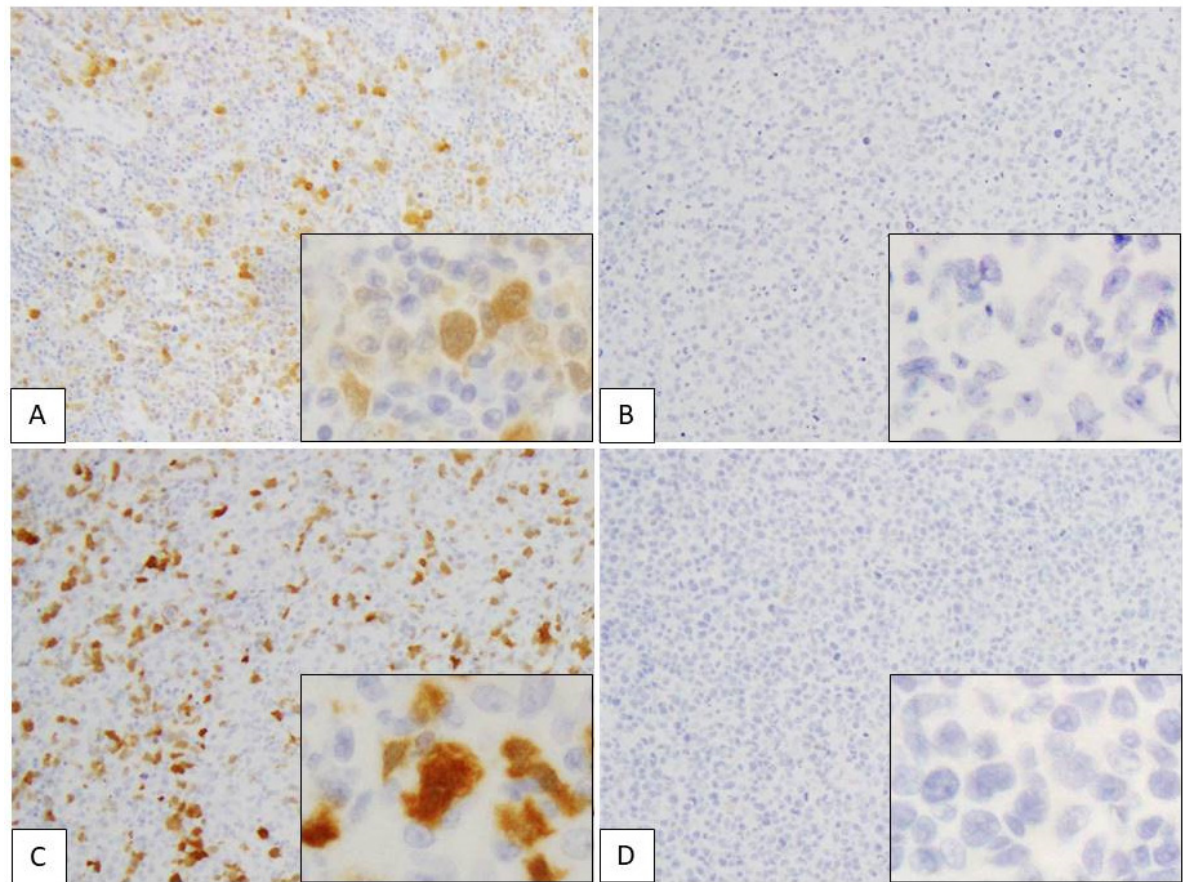
Figure 5. Immunohistochemical assessment of p16 in adult T-cell leukemia/lymphoma (ATLL) and peripheral T-cell lymphoma, not otherwise specified (PTCL-NOS). ( A – D ) p16 expression in nuclei and cytoplasm of lymphoma cells. ( A ) ATLL case showing high expression (positive cells score 3 + stain intensity score 3 = total score 6). ( B ) ATLL case showing no expression (positive cells score 0 + stain intensity score 0 = total score 0). ( C ) PTCL-NOS case showing high expression (positive cells score 3 + stain intensity score 3 = total score 6). ( D ) PTCL-NOS case showing no expression (positive cells score 0 + stain intensity score 0 = total score 0). Each subpanel shows positive cells from a high-power field of view (×400).